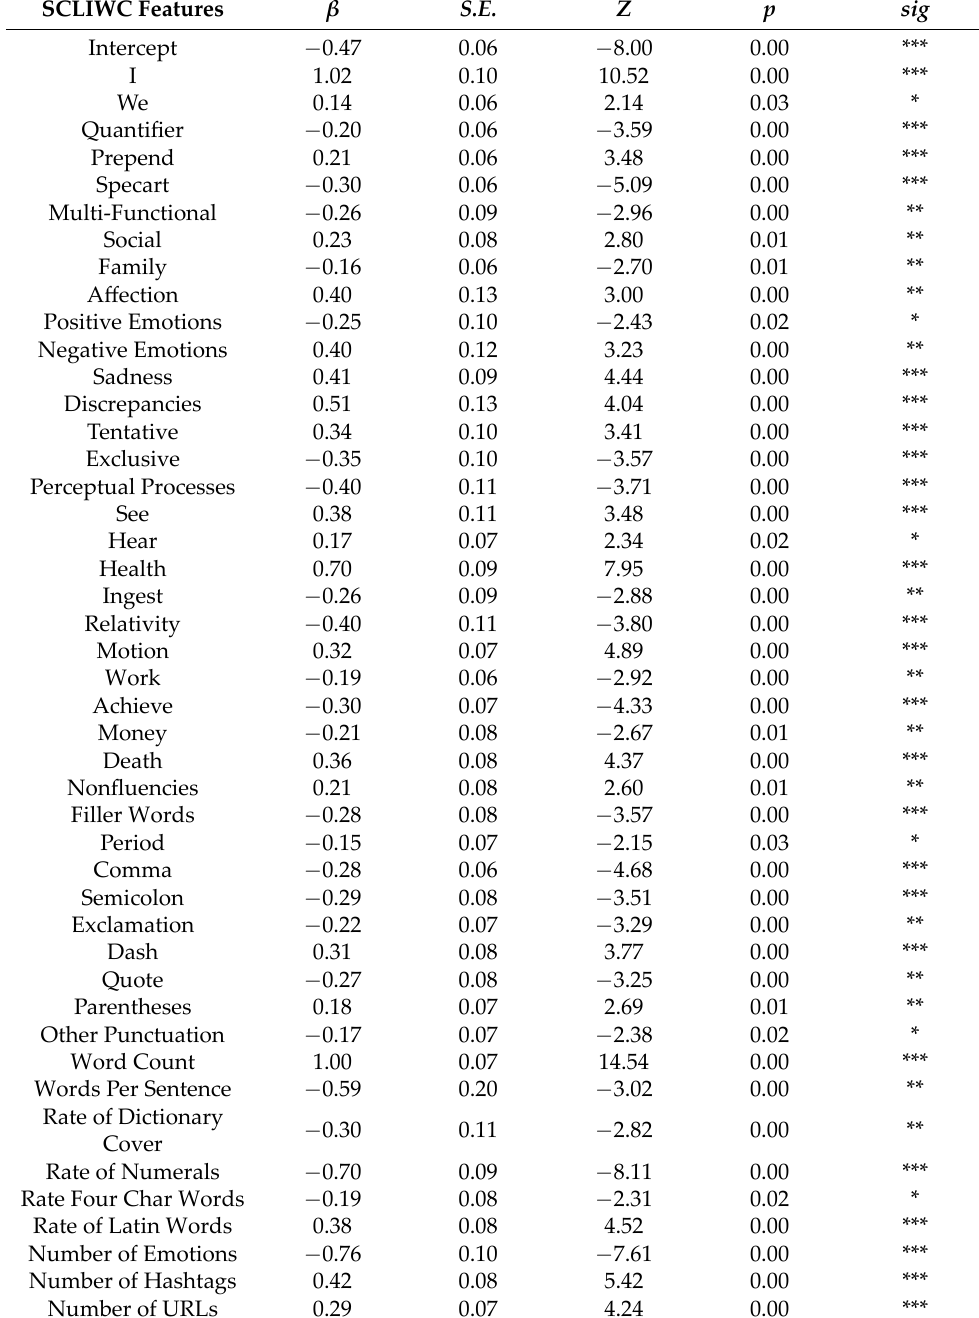
Table 1. Logistic regression model using the simplified Chinese version of LIWC (SCLIWC) features to classify the depression and control